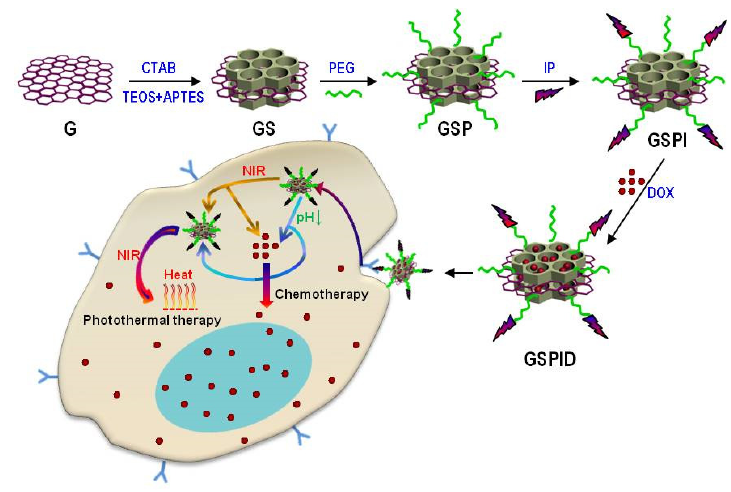
Figure 2. Design of the DOX-loaded GSPI-based system as a multifunctional drug delivery system for combined chemo-photothermal targeted glioma therapy.